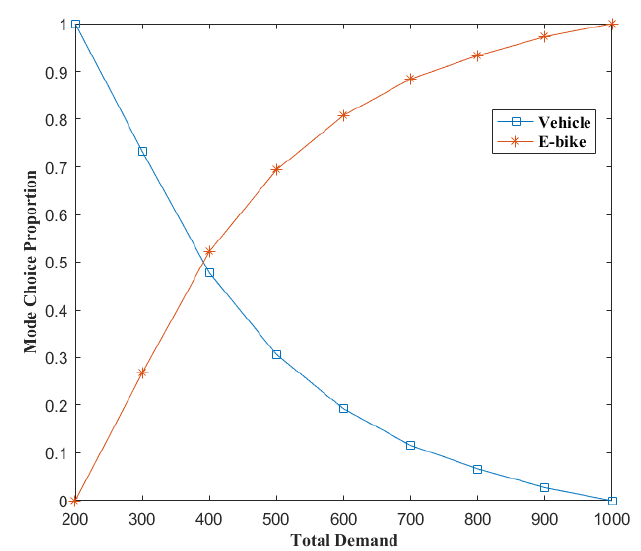
Figure 2. Mode choice proportions change with total demand for the example network.